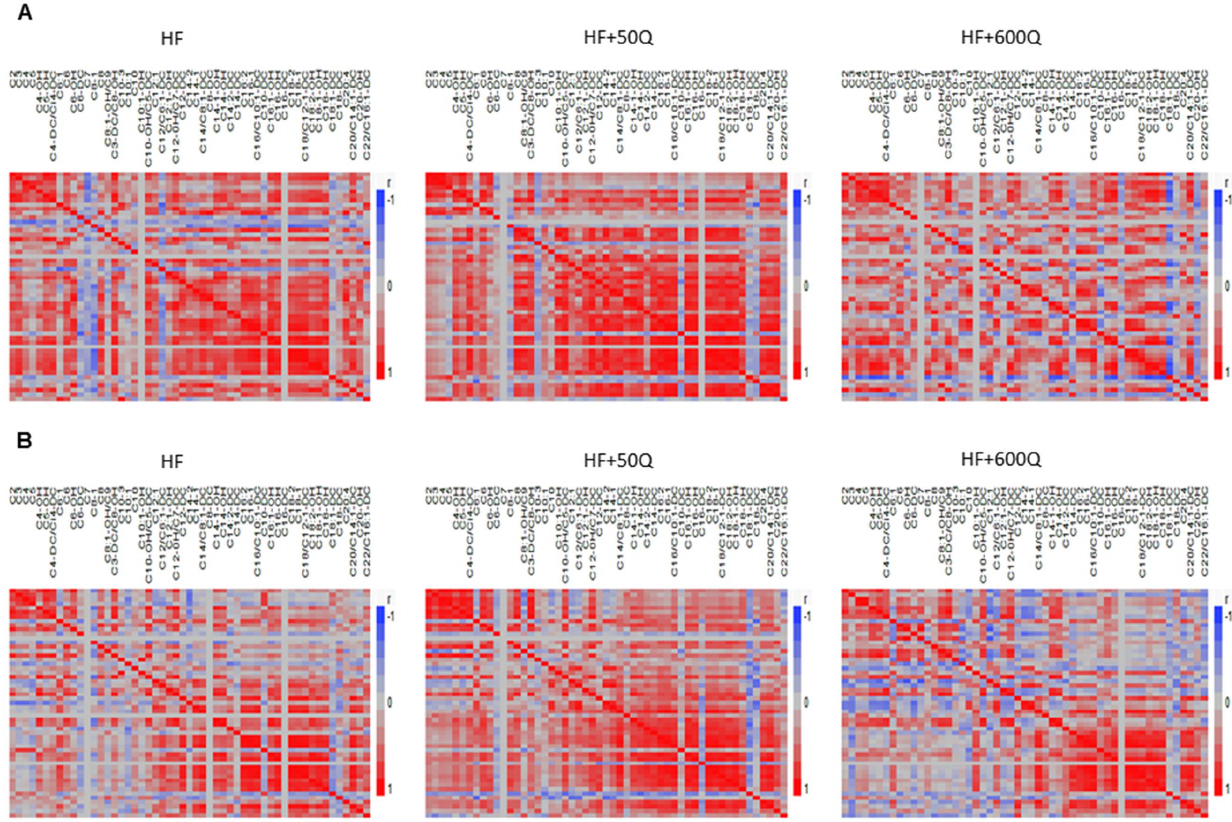
Figure 4. Acylcarnitines were measured in quadriceps muscle after 3 wks (A) and 8 wks (B) in HF, HF + 50Q and HF + 600Q, and pairwise correlation matrices were generated. Red represents a + 1 correlation and blue a 2 1. Acylcarnitine species are named at the top of each matrix, with the iteration of acylcarnitines occurring vertically.